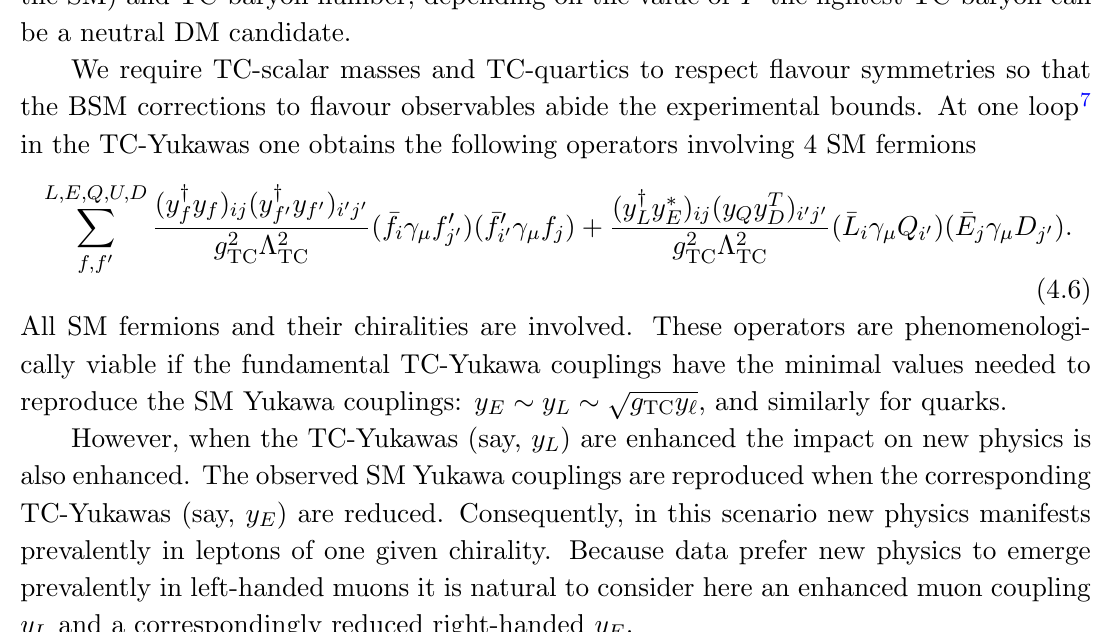
1 = 2 for the hypercharge Y of (cid:0)